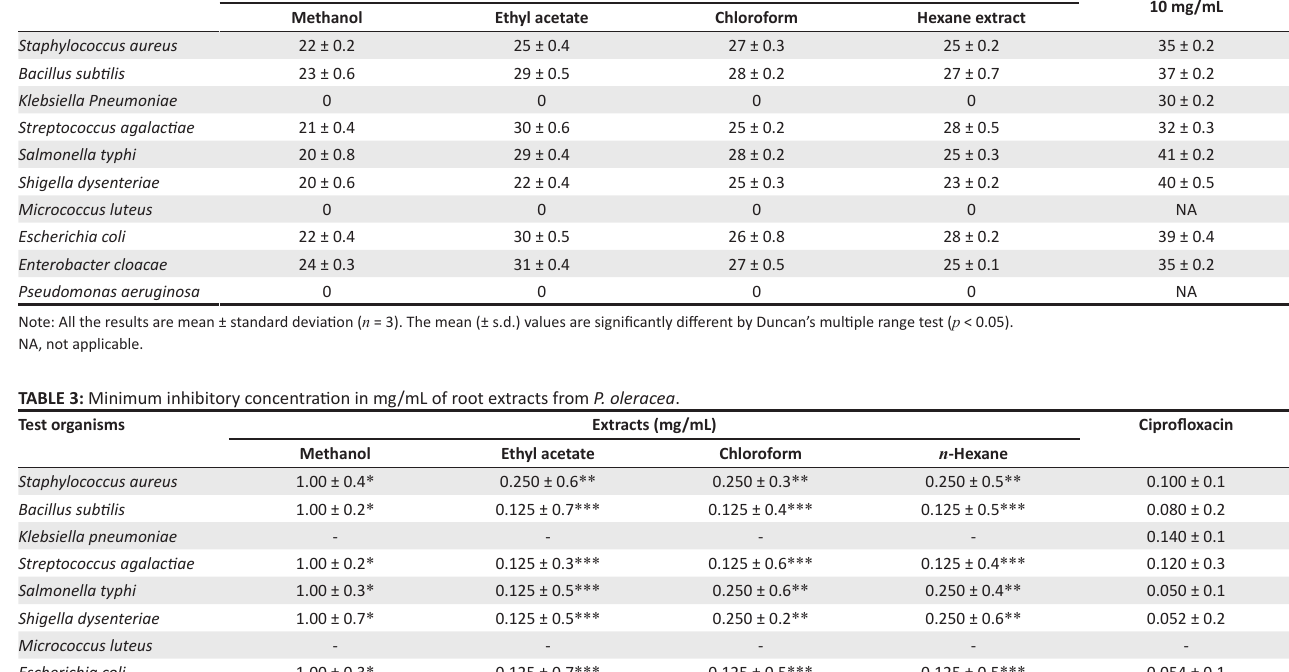
TABLE 2: Antibacterial activity (mg/mL) of root extracts of Portulaca oleracea based on zones of inhibition. Test organisms